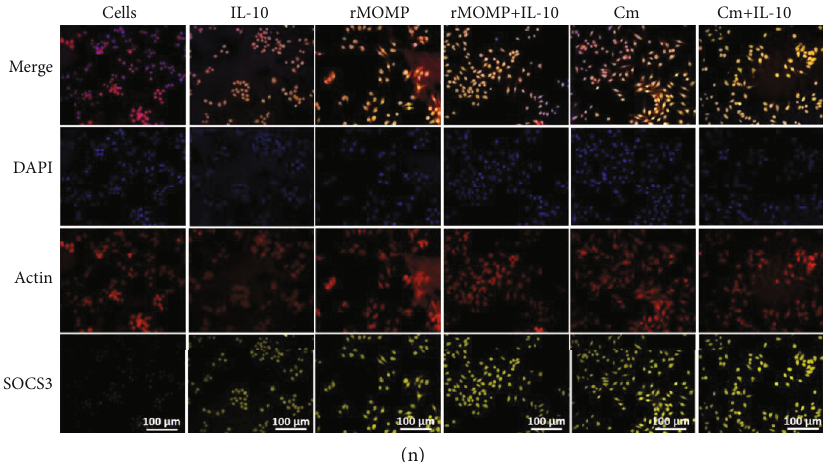
Figure 2: SOCS1 and SOCS3 transcriptional and translational expressions are di ff erentially induced and regulated by chlamydial stimulants and exogenous IL-10 in macrophages. Macrophages were exposed to dose-dependent concentrations of IL-10 (0.1, 1 and 10ng/mL) in the presence and absence of rMOMP (10 μ g/mL). RNA samples were collected at 0, 0.5, 1, 2, and 24 h post-stimulation to quantify the mRNA gene transcript of SOCS1 (A) and SOCS3 (B). RNA samples were collected at 24h from macrophages stimulated with Cm (MOI of 2) with and without dose-dependent concentrations of IL-10 to quantify SOCS1 and SOCS3 transcripts (C). Macrophages were stimulated with rMOMP (0.1, 1 and 10 μ g/mL) or Cm (MOI of 0.5, 1 and 2) with and without IL-10 (10 ng/mL) and SOCS1 and SOCS3 transcripts were quanti fi ed at 24h post-stimulation (D-E). For TaqMan qRT-PCR, all values were normalized with respect to the mRNA levels of the “ housekeeping ” gene that codes for GAPDH. Results are presented as fold increase over the control (i.e., the level in unstimulated cells. Calculations of SOCS1/SOCS3 (F) and SOCS3/SOCS1 (G) ratios in macrophages exposed to rMOMP (10 μ g/mL) or Cm (MOI of 2) in the presence and absence of IL-10 (10 ng/mL). Macrophages were exposed to rMOMP (1 μ g/mL) or Cm (MOI of 2) in the presence and absence of IL-10 to evaluate SOCS1 and SOCS3 expression by fl ow cytometry (H-M) and SOCS3 by immuno fl uorescence microscopy (N) 24h post-incubation. An asterisk indicates signi fi cant di ff erences ( P < 0.05), and P values were calculated as described in Figure 1 legend. Each bar represents the mean ± SD of samples run in triplicates, and each experiment was repeated at least 4 times with a representative experiment